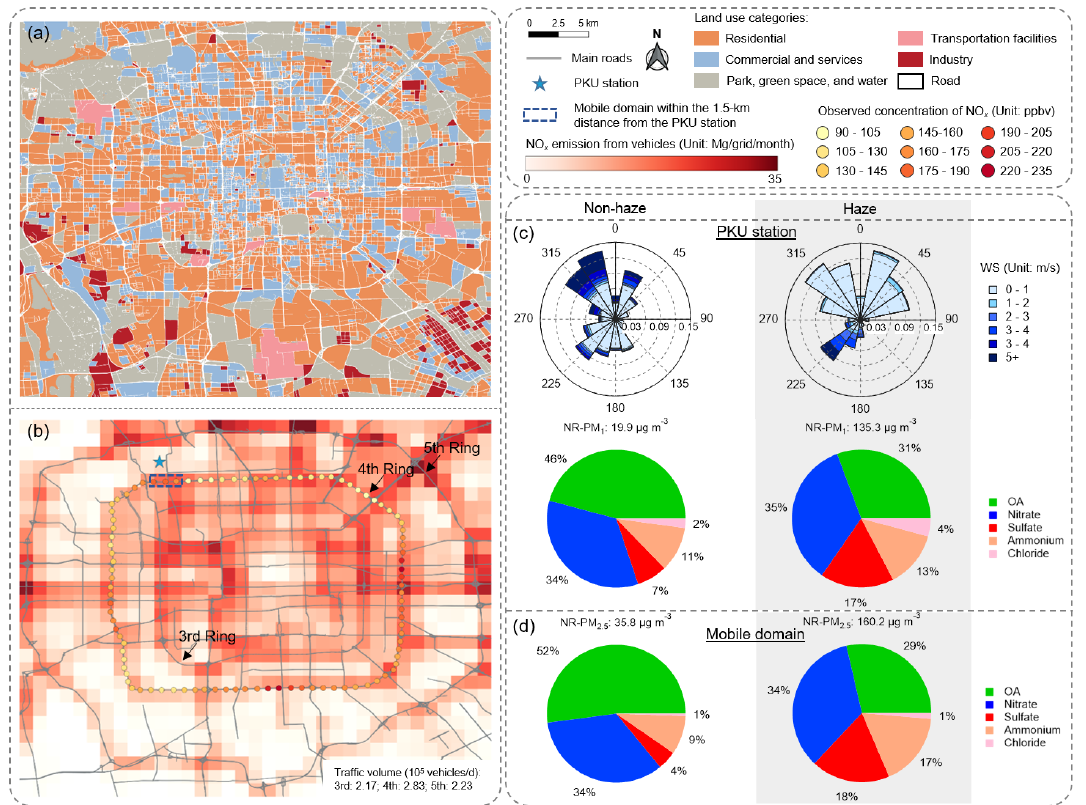
Figure 1. (a) Land use categories in the area of Beijing that were taken from the Mapping Essential Urban Land Use Categories in China (EULUC-China) database (source: © OpenStreetMap contributors 2021, distributed under the Open Data Commons Open Database License (ODbL) v1.0.; Gong et al., 2020). (b) Monthly NO x emissions from vehicle provided by Yang et al. (2019) in November 2018 and the mean NO x concentrations observed by the mobile laboratory between 09:00 and 16:00 during the non-haze measurement period on the 4th Ring Road in Beijing. (c) Wind rose diagrams and the average NR-PM 1 composition measured by LTOF-AMS at the Peking University (PKU) roof site. (d) The average NR-PM 2 . 5 composition measured by the TOF-ACSM on the mobile laboratory on the 4th Ring Road over the distance of 1.5km from the roof